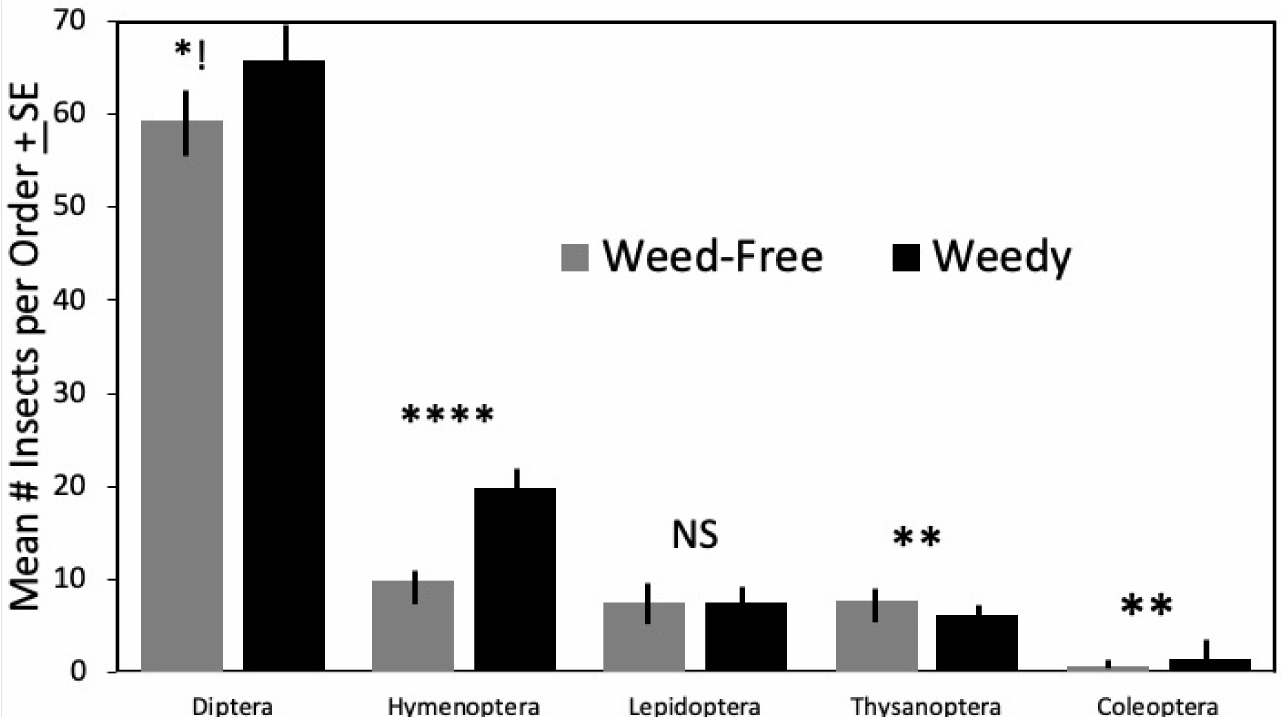
Figure 4. Mean number of insects observed in each order of potential pollinators on mango by treatment ± SE. Significant difference indicated above each type: NS p > 0.05, ** p ≤ 0.01, **** p ≤ 0.0001. Diptera *!: p = 0.057.